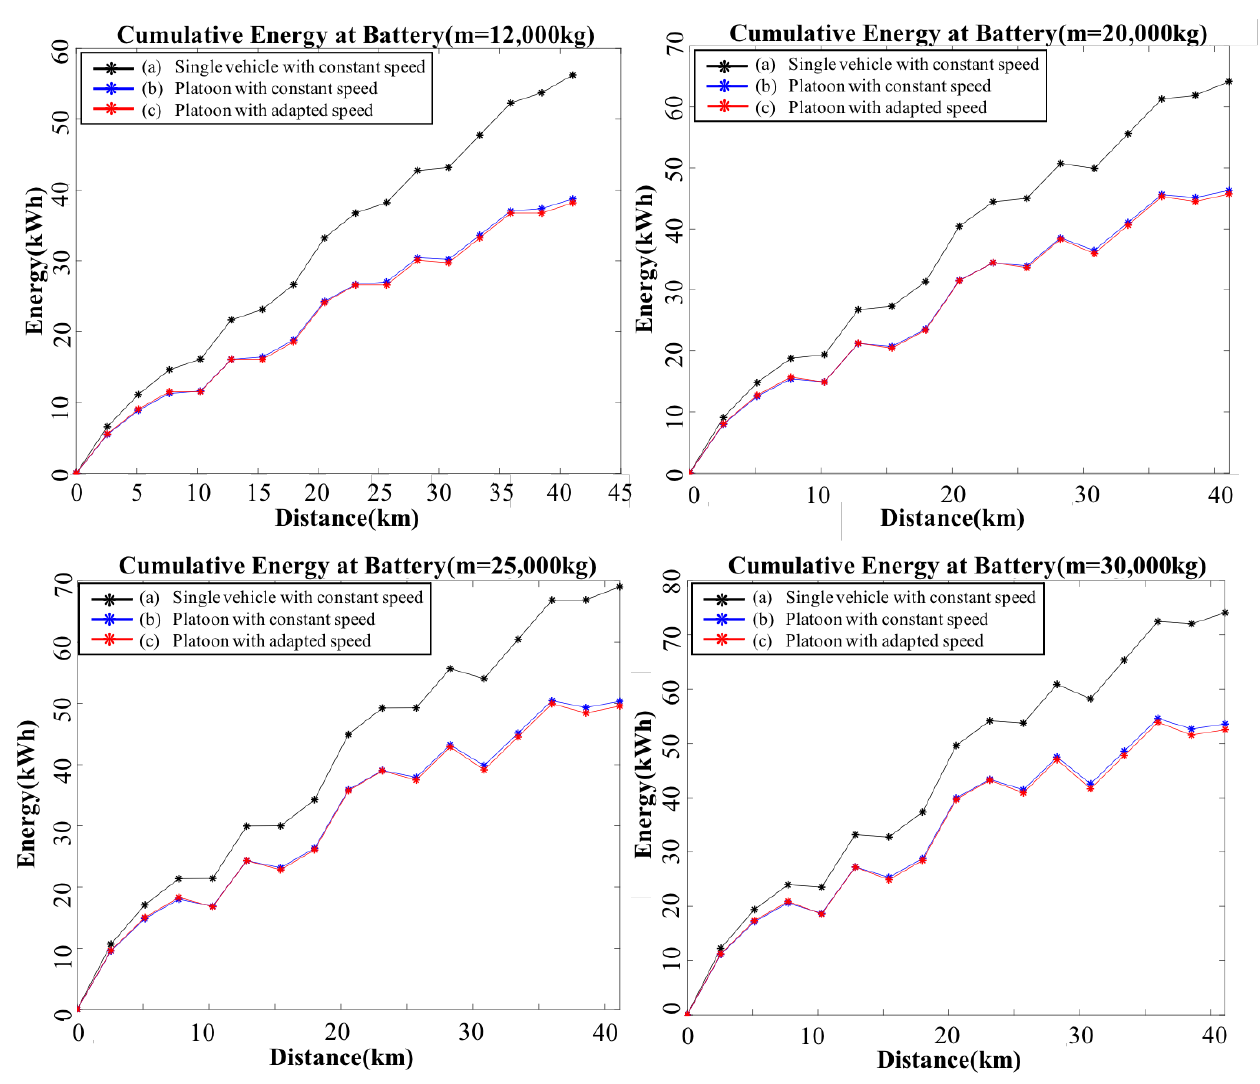
Figure 4. Energy consumption of four types of trucks with different m / C d A . For 12,000 kg trucks, the relative energy savings with regenerative braking in case (b) increased slightly compared to the case without regenerative braking, since it gained some energy through regenerative braking when declines are at − 3%. However, relative energy savings in case (c) decreased a little compared to the case without regenerative braking. This is because we need to meet the constraint of travel time. The constant speed in case (c) with regenerative braking needs to be larger than without regenerative braking, which leads to more energy consumption. For 20,000 kg, 25,000 kg and 30,000 kg trucks, both the relative energy savings with regenerative braking in case (b) and (c) decreased since the average speeds decrease compared to the case without regenerative braking.